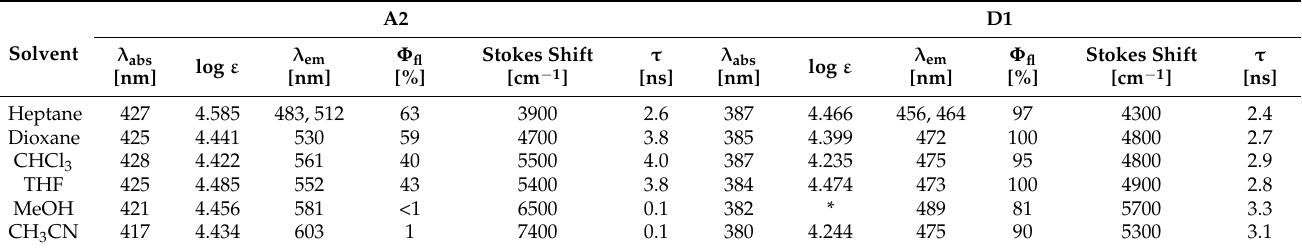
Table 7. Spectroscopic behavior of dyes A2 and D1 in different solvents.